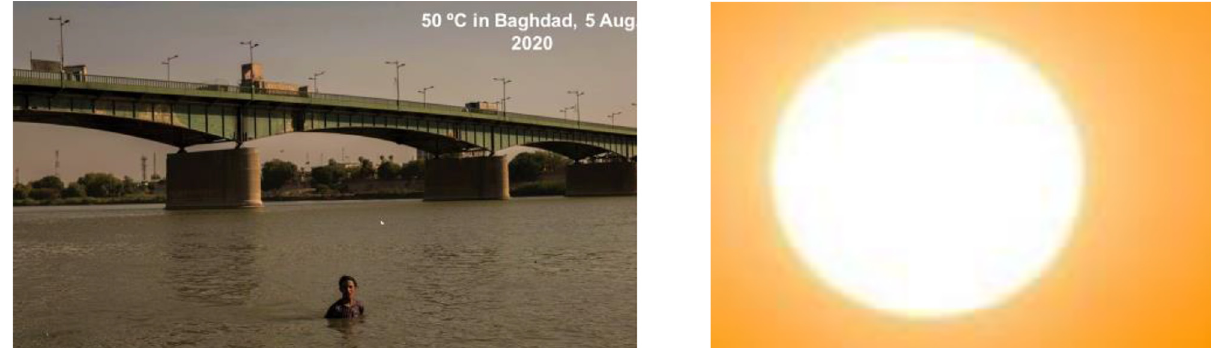
Fig. 3. Global temperature rise UK sun having 40 °